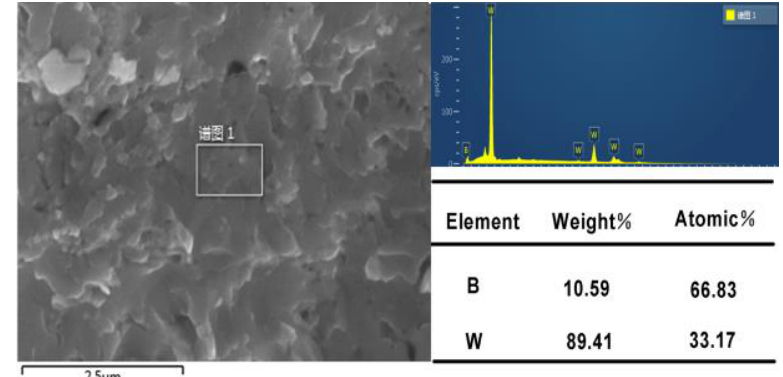
Figure 2. EDS images of as-synthesized compound fabricated at 5.2 GPa and different temperatures (1600 – 1900 °C) for 15 min using W powder and B powder (with W/B atomic ratios of 1/2.2) as precursor.